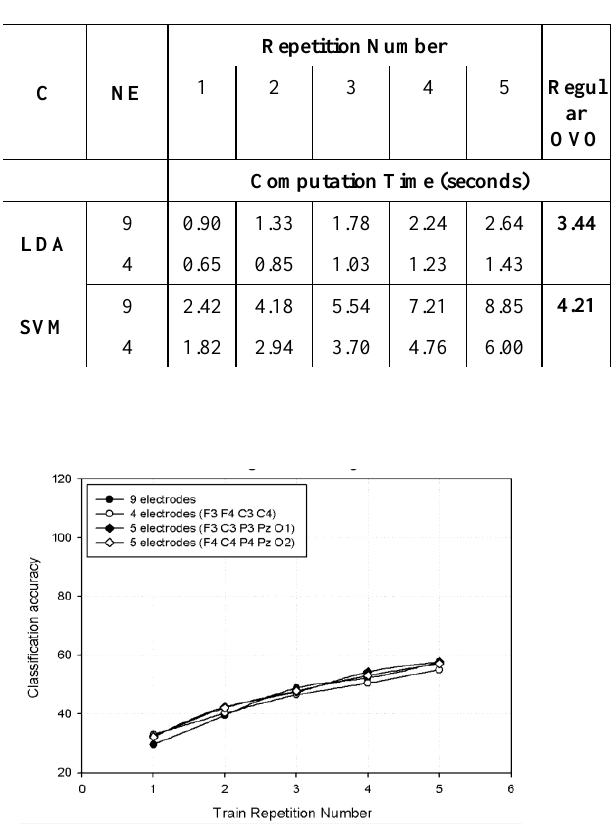
Figure 5. Change in classification accuracy for right hand imagination with LDA